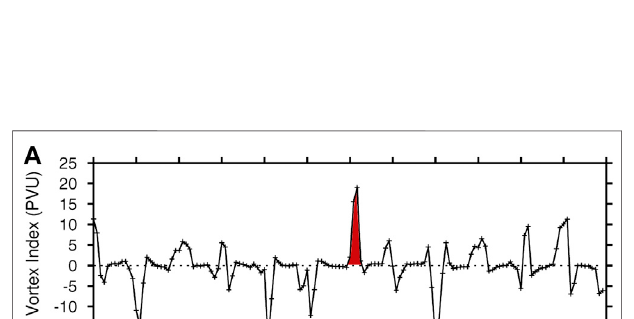
FIGURE 4 | Climatological HCl concentration (color shading) and the residual circulation ( v p , w p ) , vectors from 2005 to 2016. The vertical component of residual circulation ( w p ) has been multiplied by 10 4 .